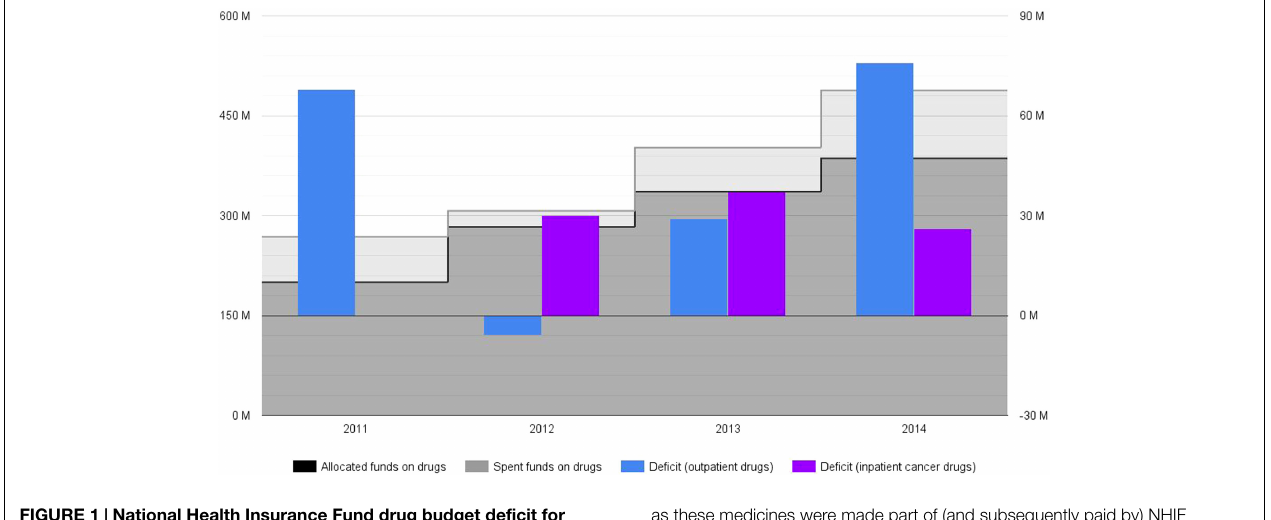
FIGURE 1 | National Health Insurance Fund drug budget deficit for 2011–2014* , ** (actual, non-discounted costs, reported in million EUR) . *No actual spending on inpatient cancer drugs is reported for 2011,